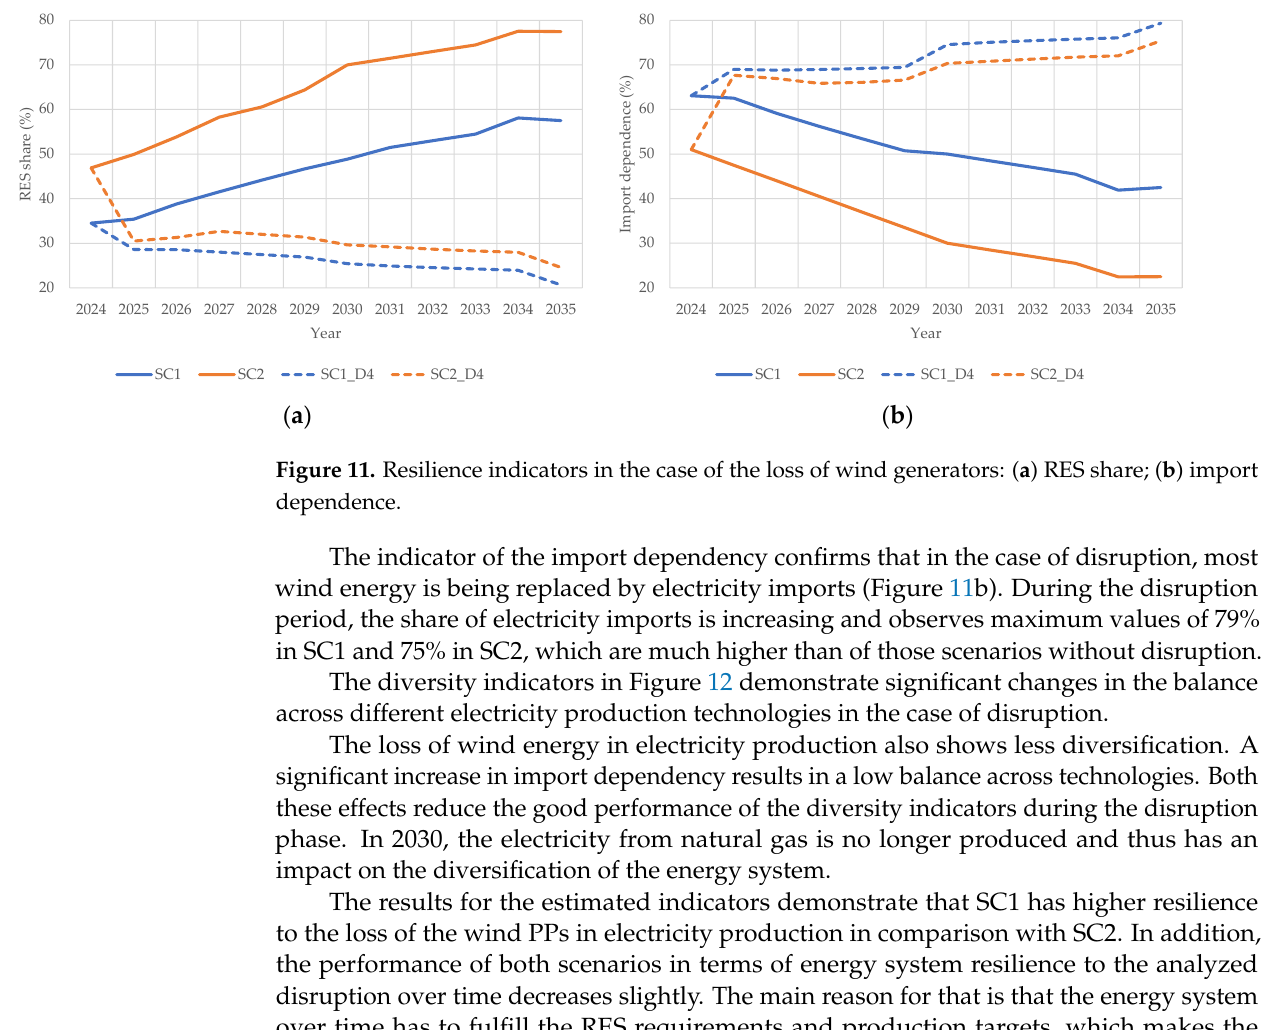
Figure 12. Diversity indicators in the case of the loss of wind generators: ( a ) SWI; ( b ) HHI.